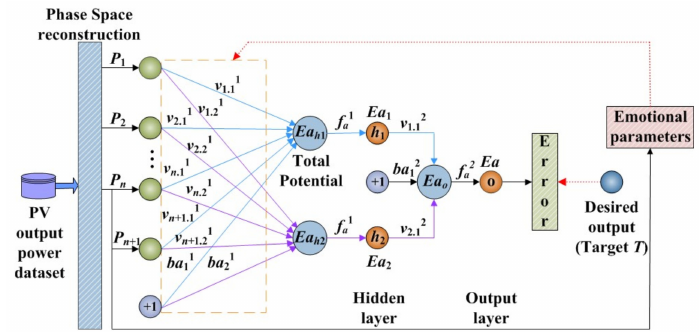
Figure 4. The localized emotion reconstruction in the amygdala part of the localized emotion reconstruction emotional neural network